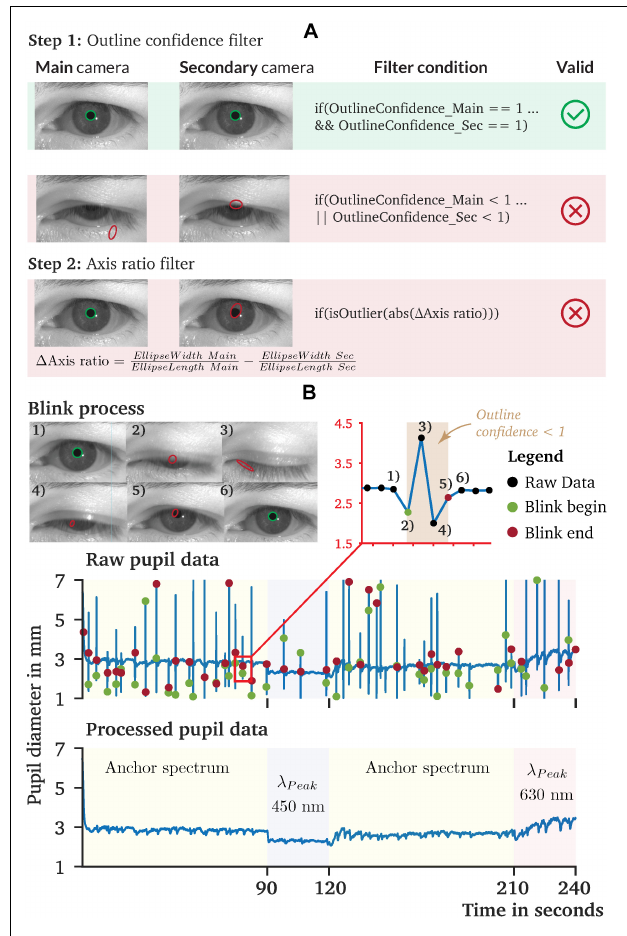
FIGURE 8 | Recorded pupil data and proposed pre-processing procedure of pupil diameter data collected by PupilEXT . (A) A two-step pre-processing procedure is proposed, which uses the outline confidence and the axis ratio of the cameras’ tracked ellipses. (B) Recorded pupil data from our sample experiment to illustrate the performance of PupilEXT . The outline confidence can be used to identify eye occlusions in the data approximately. The two-step pre-processing can remove artifacts and other unnatural physiological pupil diameter